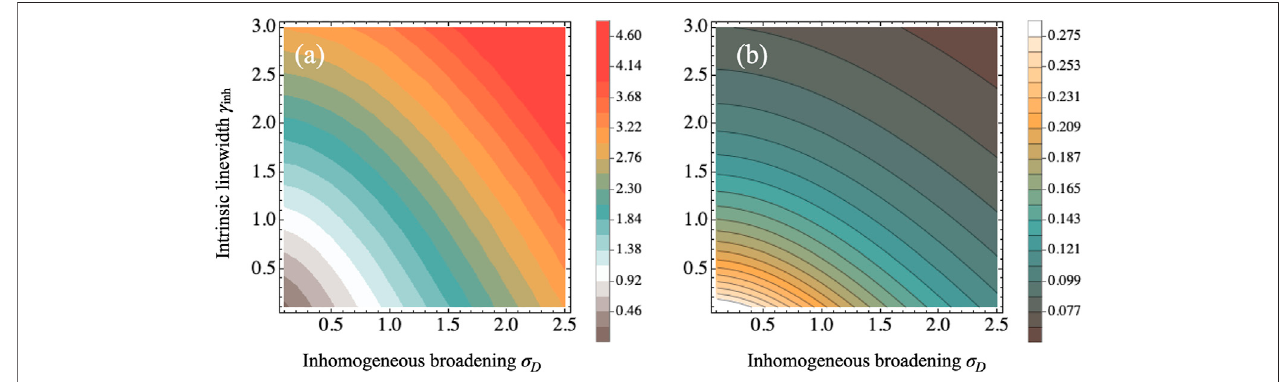
FIGURE 3 | (A) Full width half maximum of the f -state resonance as a function of the intrinsic linewidth γ inh and the inhomogeneous broadening σ D . (B) ETPA probabilityaccordingto Eq.8 inunitsof σ ( 2 ) γ